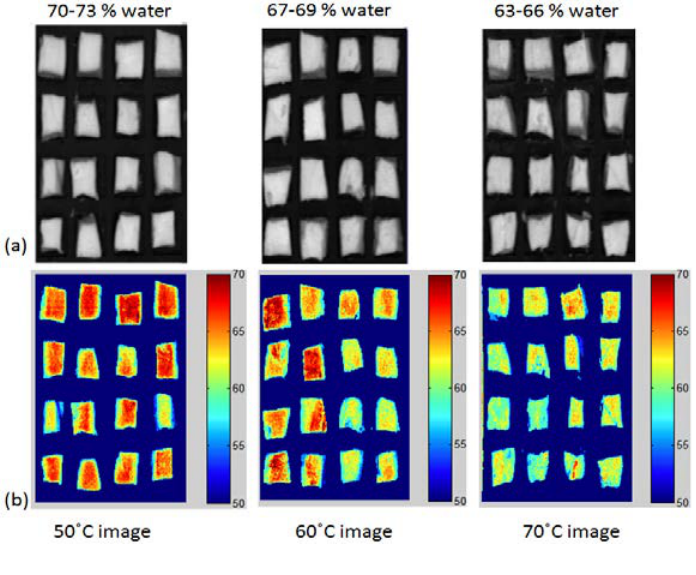
Figure 8. ( a ) Original hyperspectral images; ( b ) Chemical images of moisture